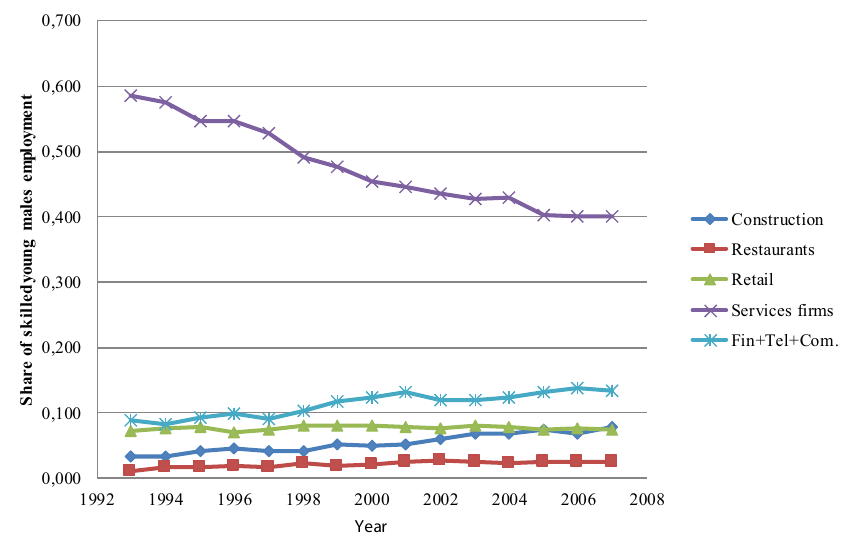
Fig.4 Mainindustriesemployingskilledyouth,males. Source :SpanishEmploymentSurvey(EPA):Waves 1992–2008. Skilled youth defined as those with high school or